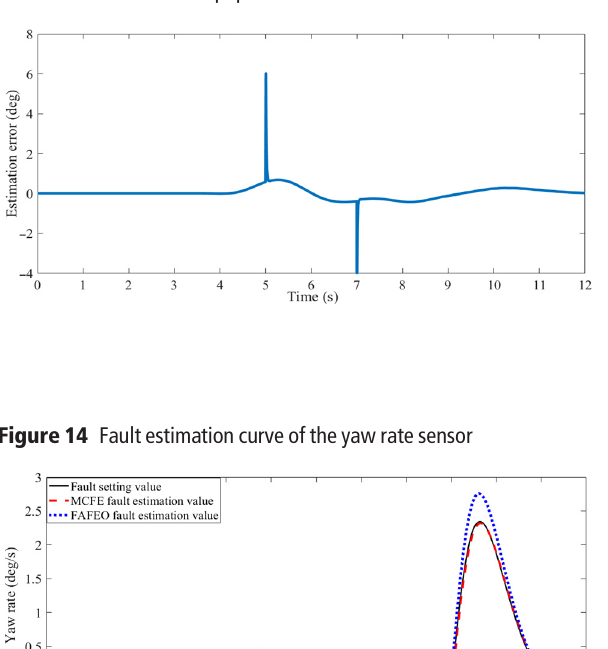
Figure 13 Fault estimation error curve of the rotation angle sensor by estimation method in this paper